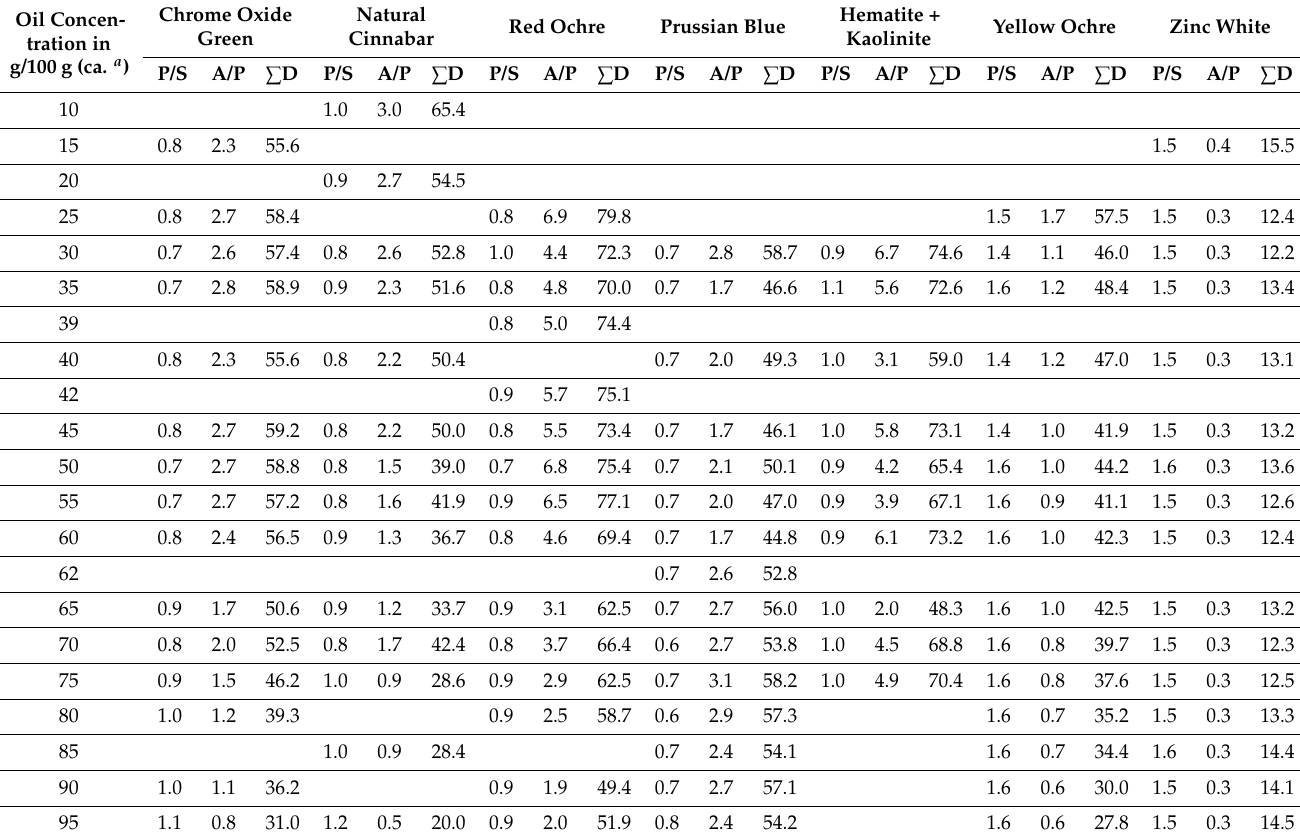
Table 1. Palmitic acid to stearic acid ratio (P/S), azelaic acid to palmitic acid ratio (A/P), and the sum of the relative content of dicarboxylic acids ( ∑ D) in % of the studied pigment and linseed oil mixtures. The name of the pigment represents the studied pigment and linseed oil